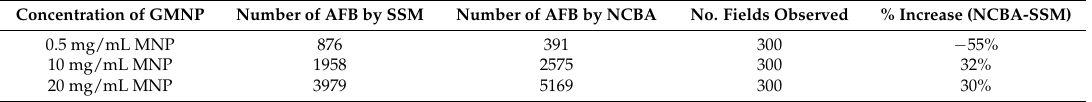
Table 2. Optimization of the glycan-functionalized magnetic nanoparticles (GMNP) concentration. Concentration of GMNP Number of AFB by